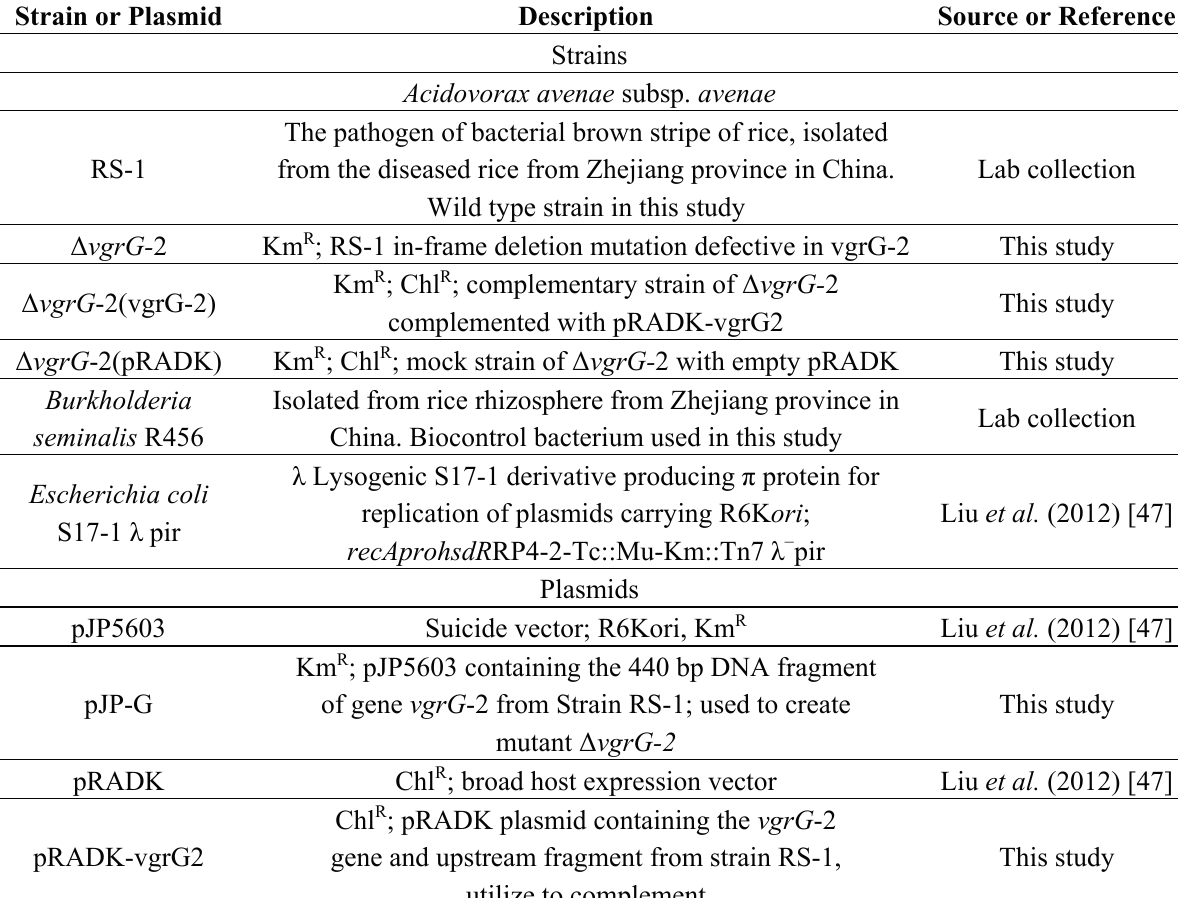
Table 2. Strains and plasmids used in this